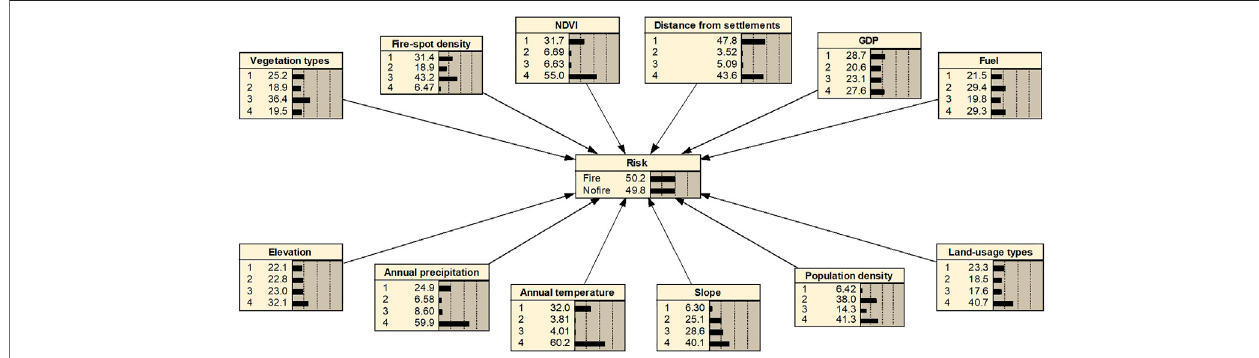
FIGURE 8 | The model framework based on NB.